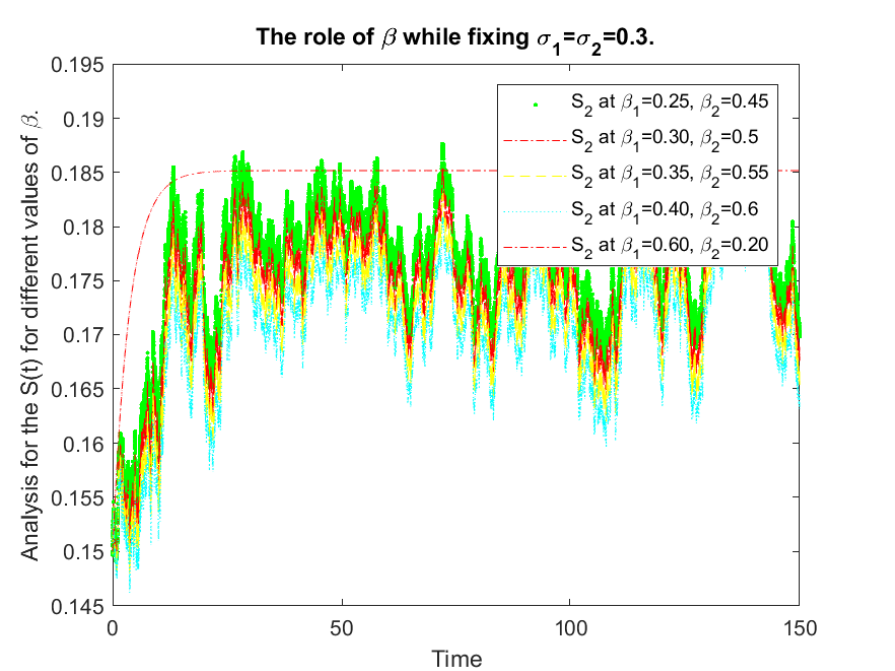
Figure 13. Comparative analysis of S 2 ( t )